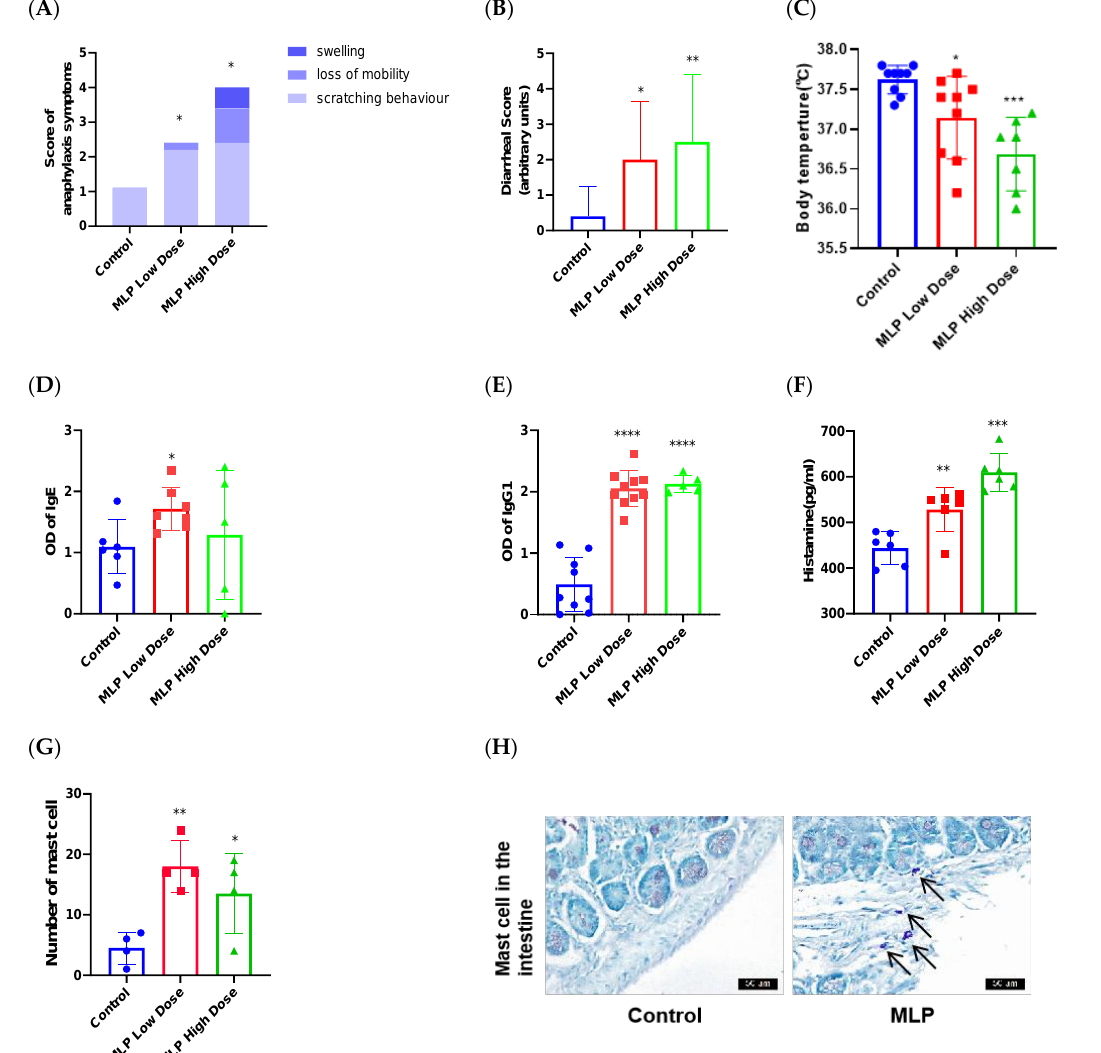
Figure 3. The score of hypersensitivity symptoms ( A ), diarrhea ( B ), and rectal temperature ( C ) in the MLP low-dose group and MLP high-dose group. Levels of specific antibodies (IgG or IgE) (( D , E ), fix the background) and histamine ( F ) in sera from mice exposed to low-dose MLP, high-dose MLP, or PBS (control group) were detected by ELISA. The number of mast cells ( G ) in jejunum following MLP and saline challenges were assessed by morphometric analysis of toluidine blue-stained cells ( n = 4 mice per group). Histopathological analysis of jejunum (( H ), arrows point at mast cells). Each point representsdata from an individual mouse, and values are expressed as means ± SD ( n ≥ 6). * p < 0.05, ** p < 0.01, *** p < 0.001,**** p < 0.0001 by two-tailed unpaired Student’s t -test where indicated or Mann–Whitney U test.